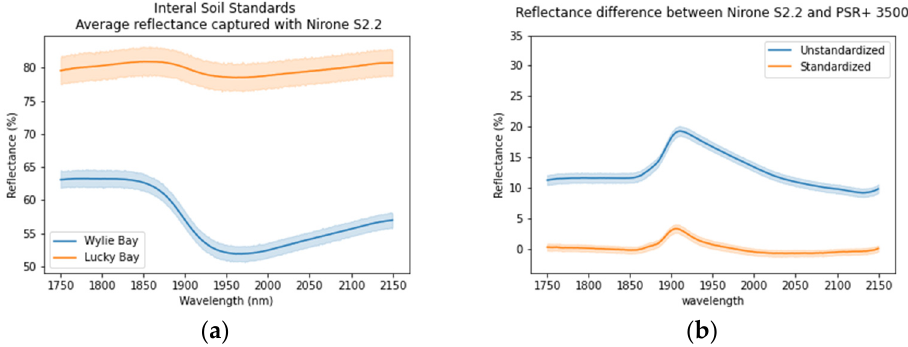
Figure 7. ( a ) Wiley Bay and Lucky Bay spectral signatures (average reflectance and 95% confidence interval), as captured on Nirone S2.2 ( b ) Spectral differences between the reflectance captured with